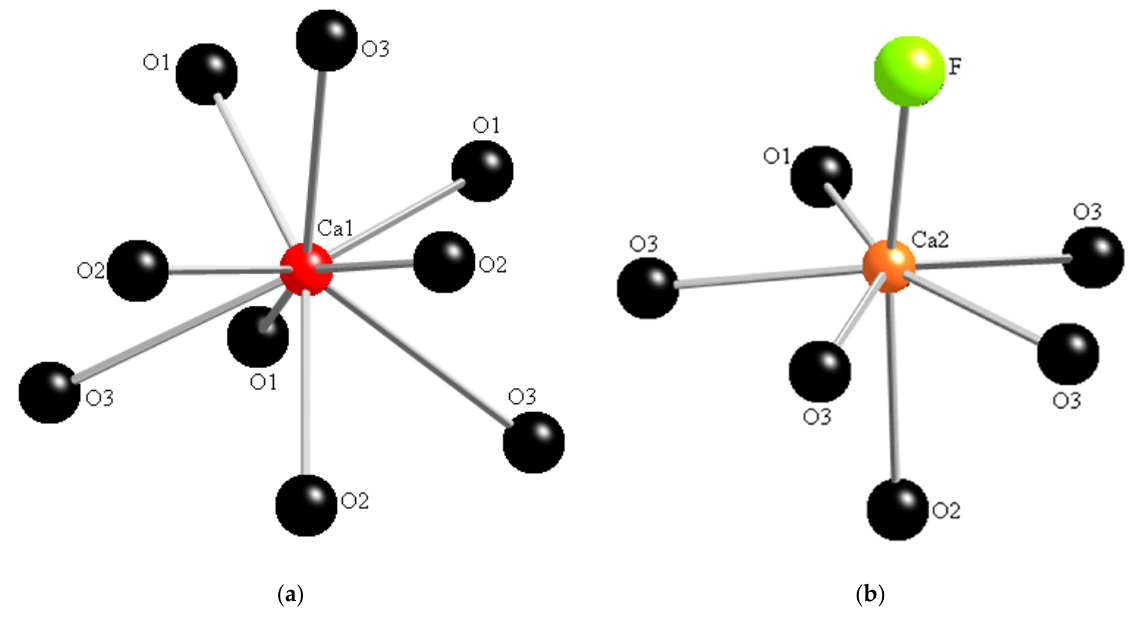
Figure 2. Coordinations of ( a ) Ca1 site by nine O ions, and ( b ) Ca2 site by one F and six O ions in F-Ap. The average <Ca1-O>[9] and <Ca2-O,X>[7] distances are compared across natural Ap solid solutions below.